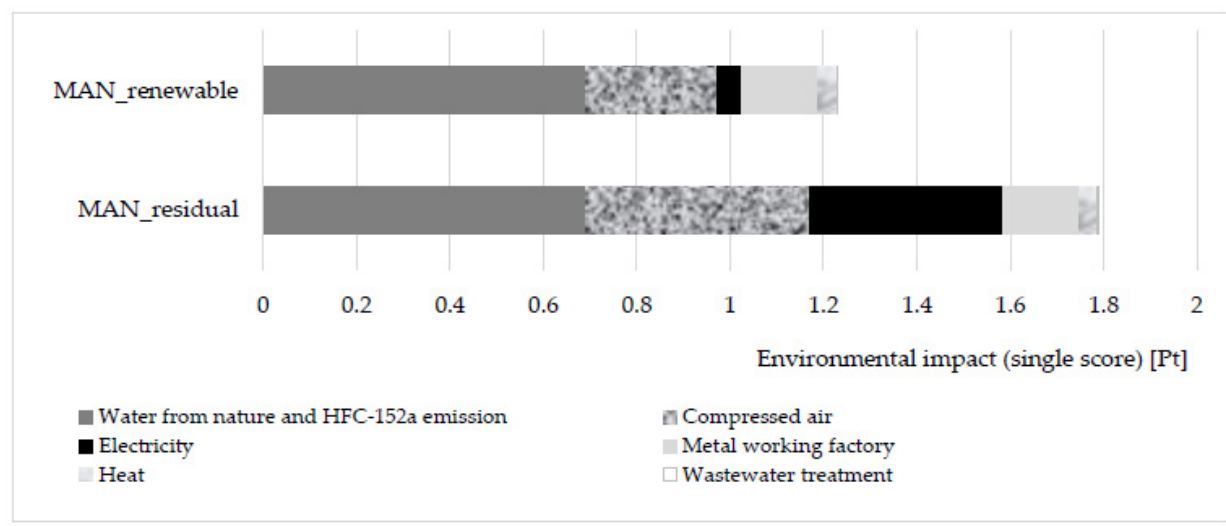
Figure 2. Environmental impact of the life cycle stage Manufacturing of refrigerator (MAN) per 1 refrigerator (1.788 Pt = residual, 1.230 Pt = renewable, decrease by 31%).